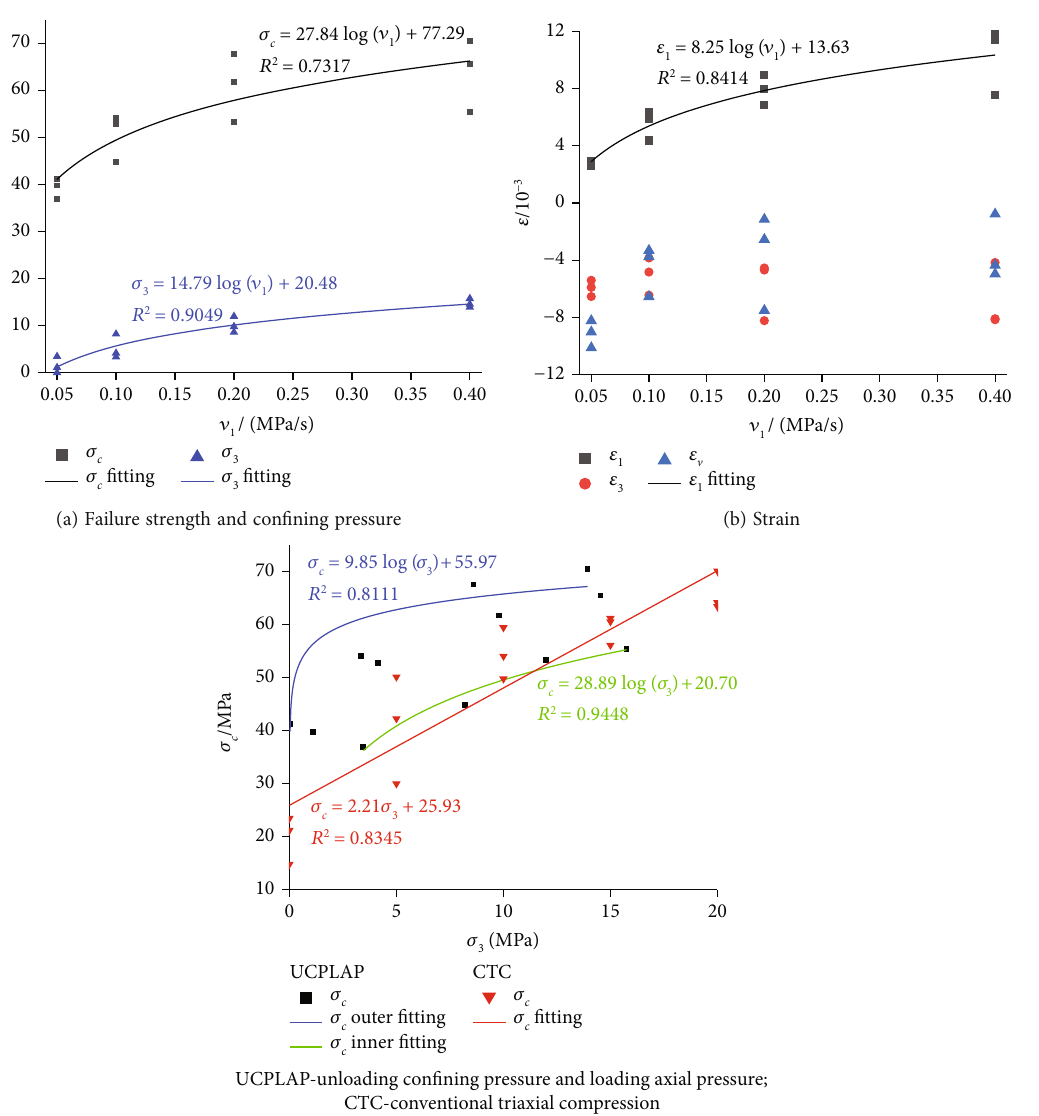
Figure 5: The relationship among stress, strain, and loading axial pressure rate. UCPLAP: unloading con fi ning pressure and loading axial pressure; CTC: conventional triaxial